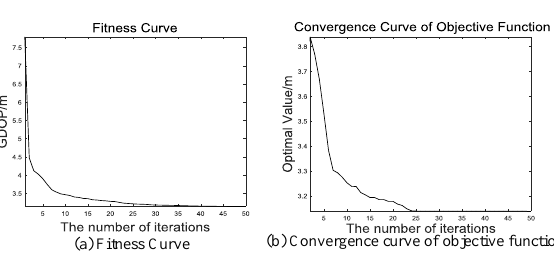
Fig. 6. Launch configuration.